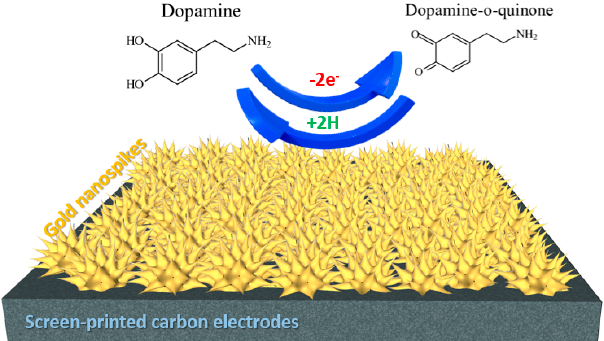
Figure 2. ( a ) Cyclic voltammograms of Au nanostructured-modified SPCE in a 0.5 M H 2 SO 4 solu- tion. Inset shows the correlation curve between the reduction peak current with electrodeposition applied potential; ( b ) ECSA value for each SPCE with different electrodeposition applied poten- tial.